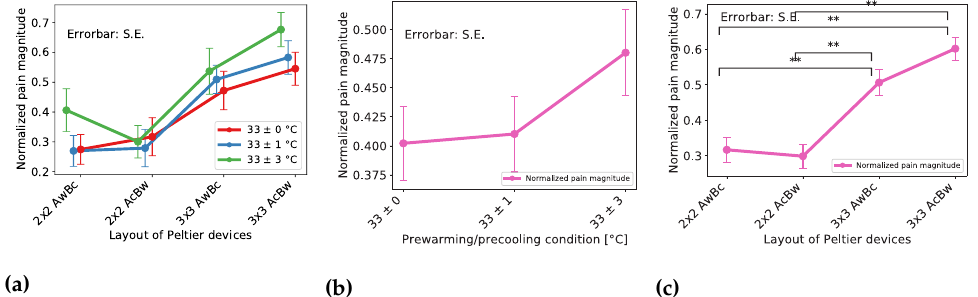
Figure 9. Magnitude estimation of the pain sensation result of spatial distribution effect. The ** indicates a significant difference of p < 0.01. ( a ) Effect of layout of Peltier device and pre- cooling/pre-warming condition on magnitude estimation rate ( b ) Averaged effect of pre-cooling/pre- warming condition on magnitude estimation rate ( c ) Averaged effect of layout of Peltier device on magnitude estimation